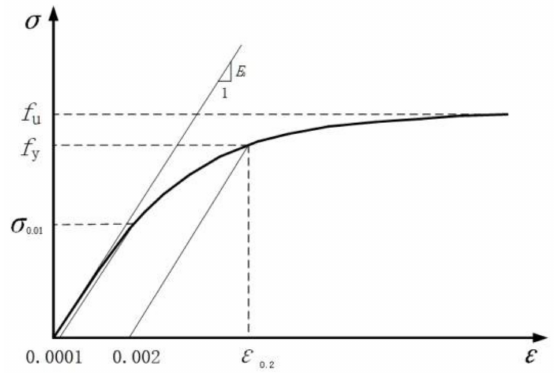
Figure 5. Stress–strain curve of stainless steel.